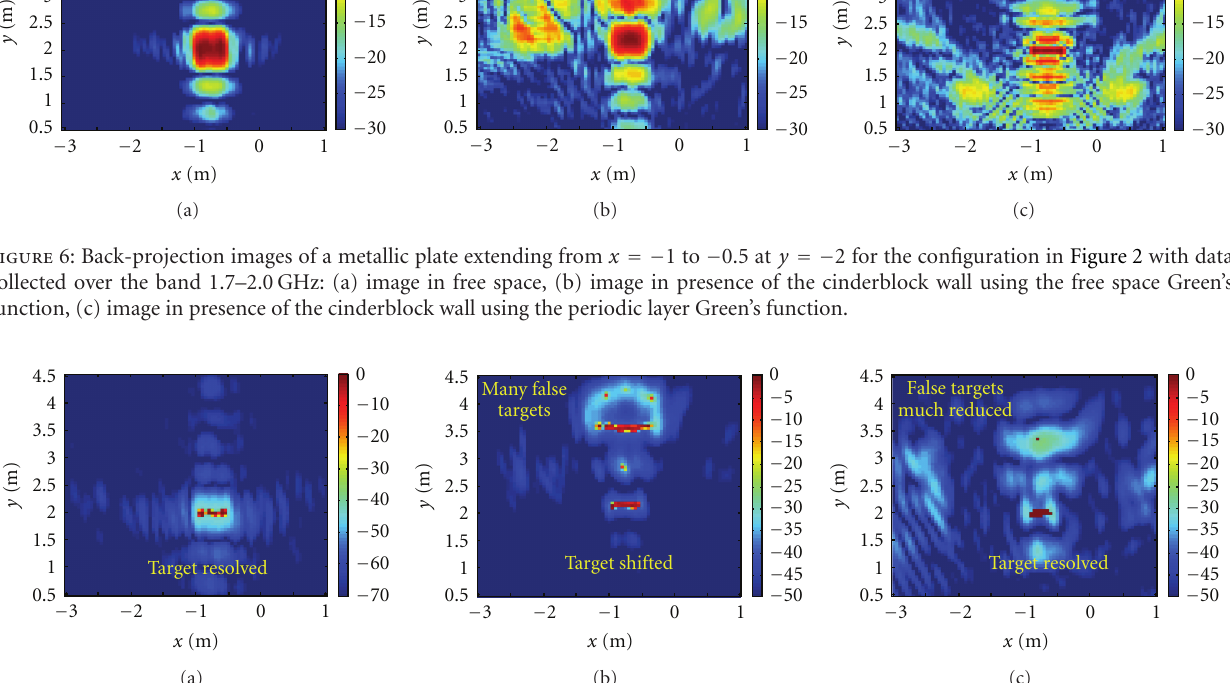
Computationally, construct of the central PSF and the initial back-projection image from the forward model and its Hermitian adjoint are the most time-consuming